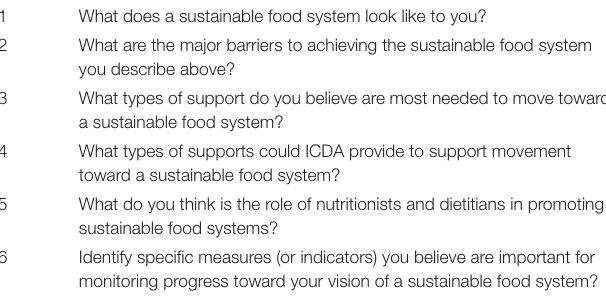
TABLE 2 | Questions from the ICDA member Delphi Inquiry